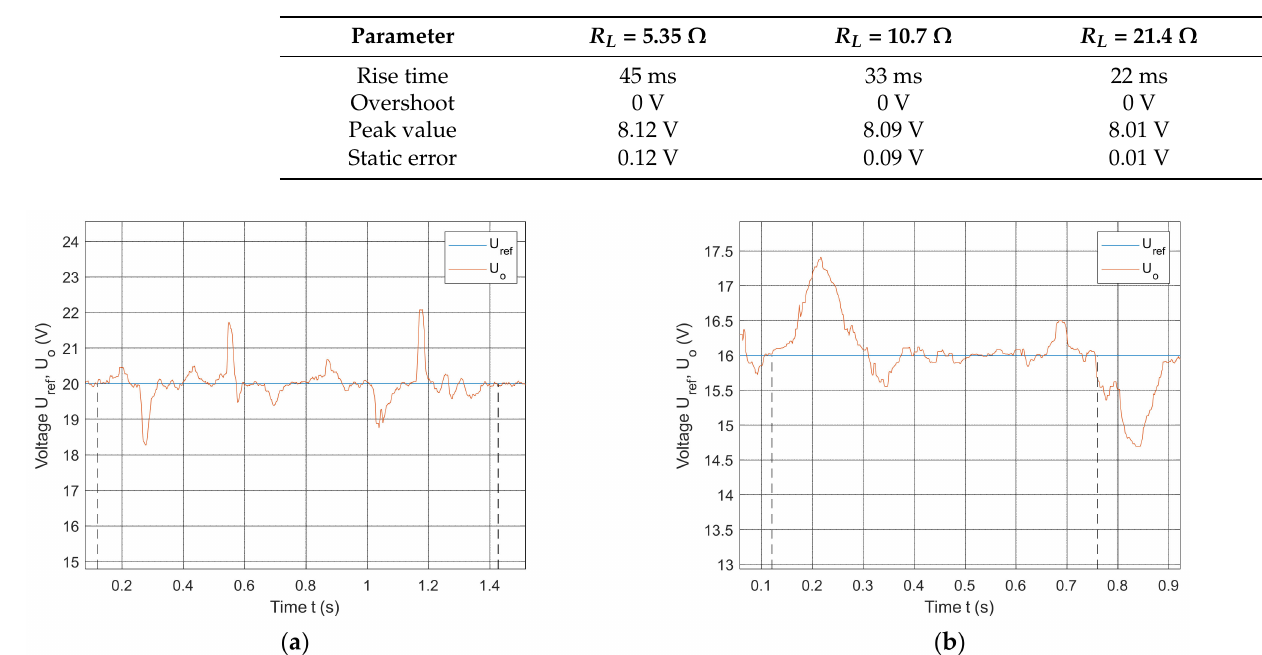
Figure 13. Output voltage control with different rectifier loads. Table 7. Performance evaluation of IPT system under different loading, when changing the reference value U ref from 4 V to 8 V.